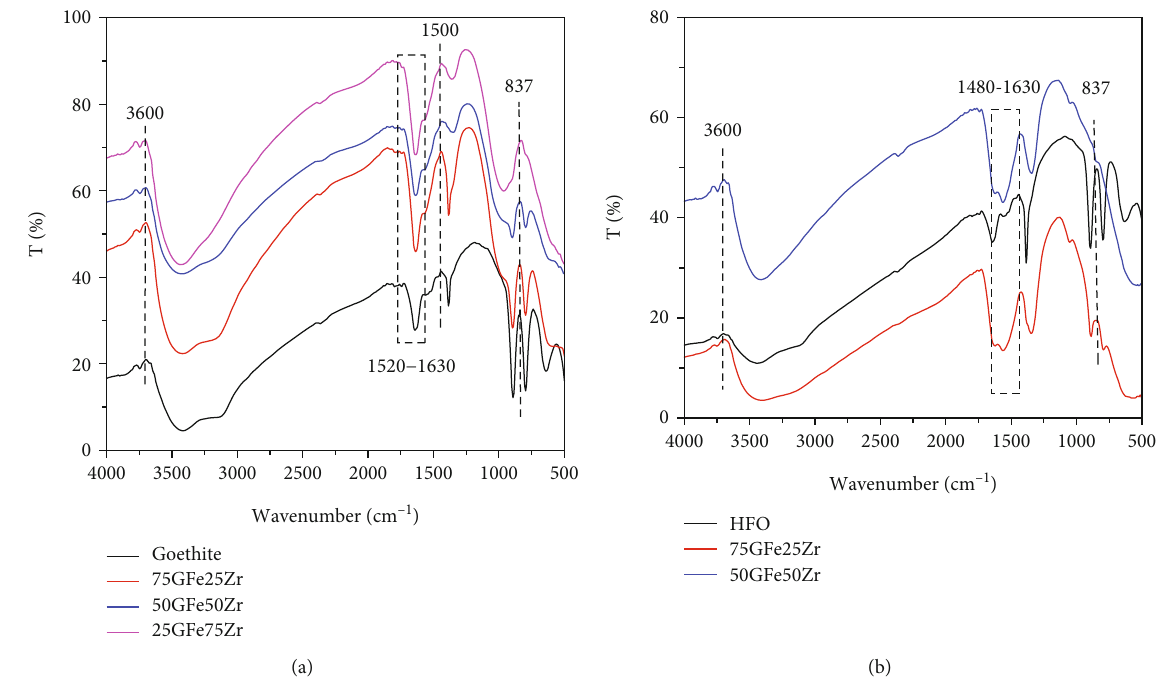
Figure 3: FTIR spectra of catalyst samples used in the degradation of 4-nitrophenol. Table 3: Main textural parameters of catalysts prepared in this study.